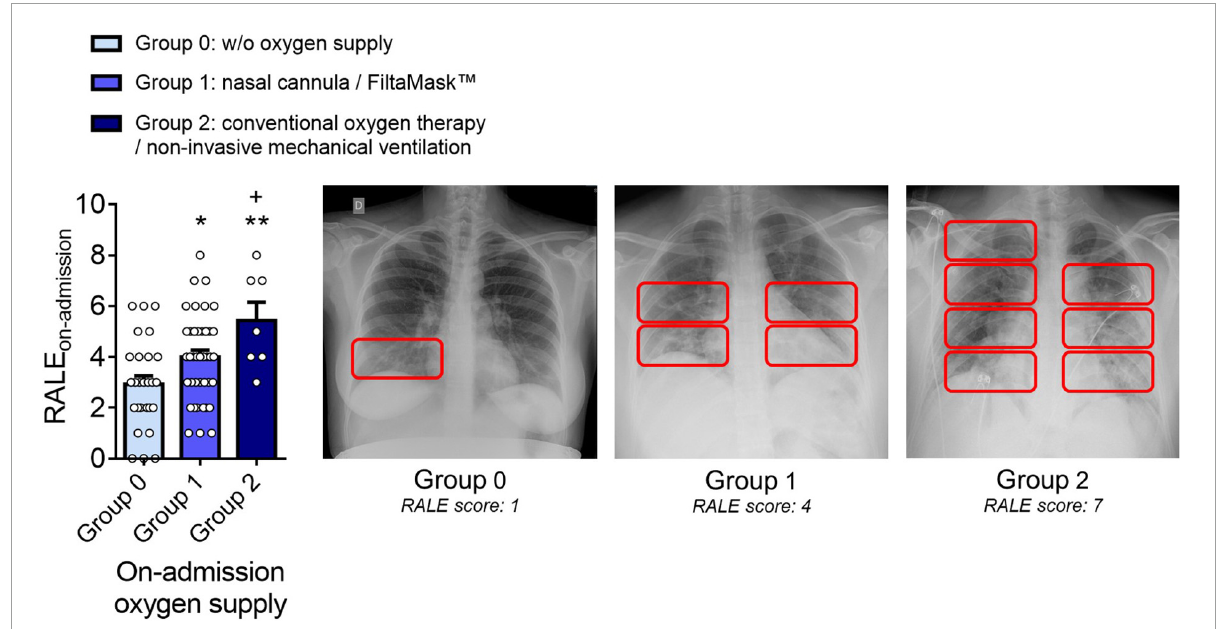
FIGURE2 The RALE score correlates with the oxygen supply administrated, validating oxygen supply as an indicator of COVID-19 severity. Distribution of the RALE score according to admission oxygen supply groups: group 0 (mild COVID-19, without oxygen supply, n = 27), group 1 (moderate COVID-19, nasal cannula/FiltaMask TM , n = 44) and group 2 (severe COVID-19, conventional oxygen therapy/non-invasive mechanical ventilation, n = 7). Representative radiographic images with the respective RALE scoring are shown. Values are expressed as mean ± SEM. * p < 0.05 or ** p < 0.01 relative to group 0, and + p < 0.05 relative to group